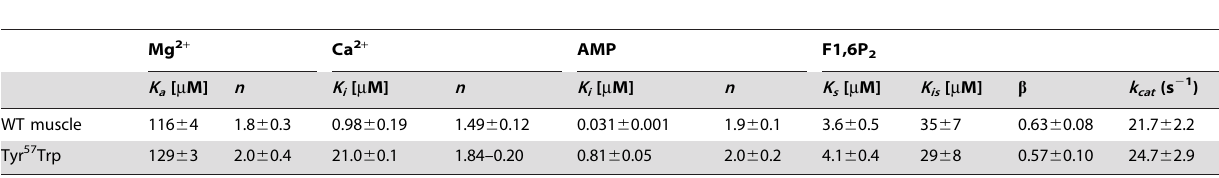
Mg 2 + Ca 2 + AMP F1,6P 2 K a [ m M]